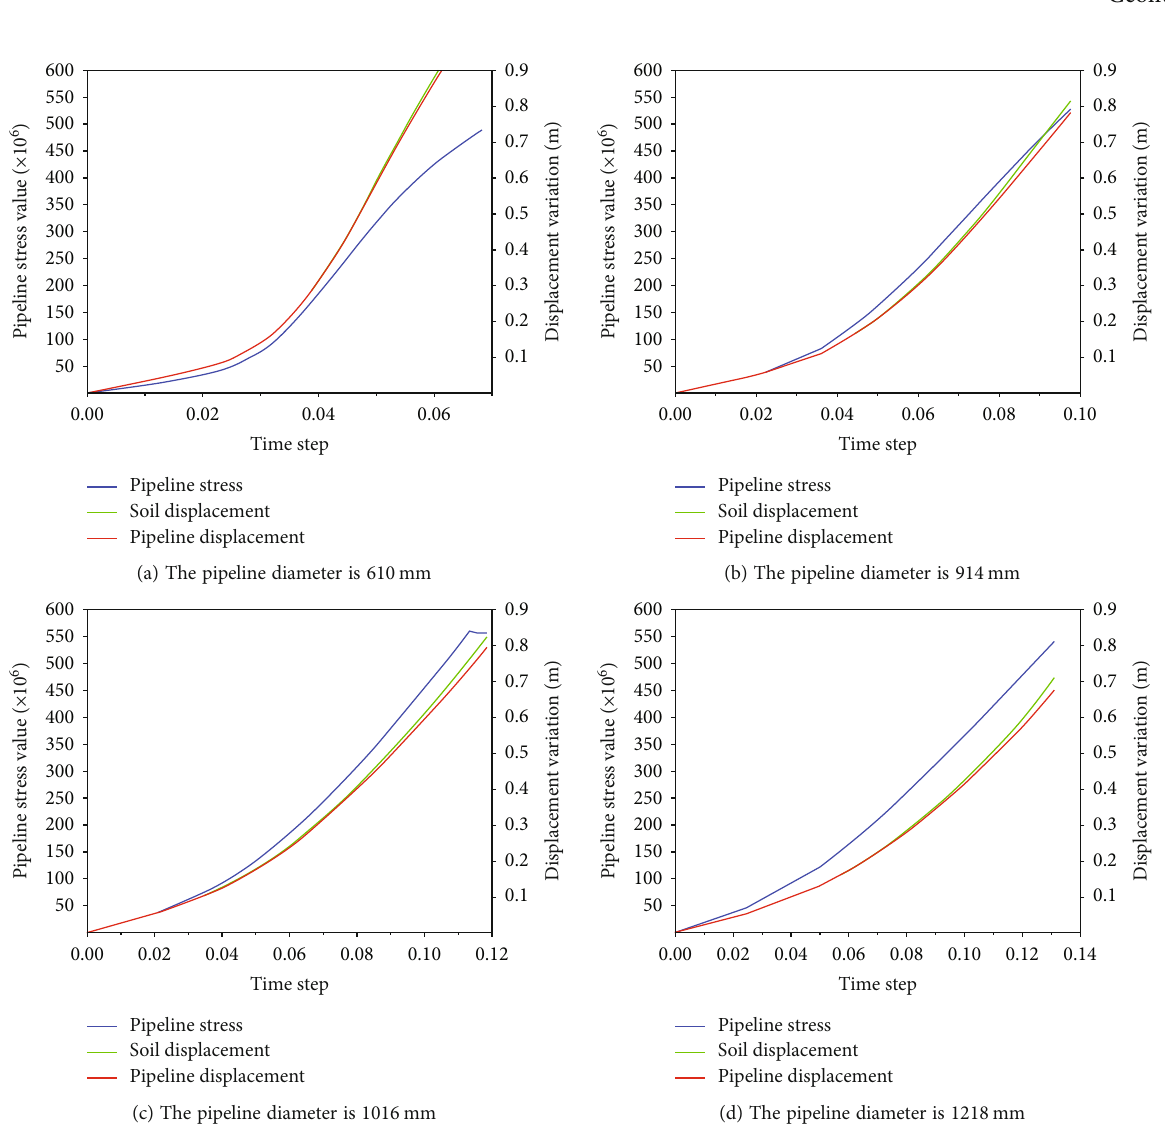
Diameters. Figure 19 shows the soil displacement nepho- grams under four di ff erent pipeline diameters. It can be seen from the fi gure that when the pipeline diameter is 610 mm, the soil displacement in the middle of the subsidence area is large, and the soil displacement on both sides is small, indicating that the smaller the pipeline diameter, the smaller the upward supporting force on the soil. When the pipeline diameter is 610 mm, the maximum displacement of soil is 1.17 m. When the pipeline diameter is 1218 mm, the maxi- mum displacement of the soil is 0.74 m, indicating that the